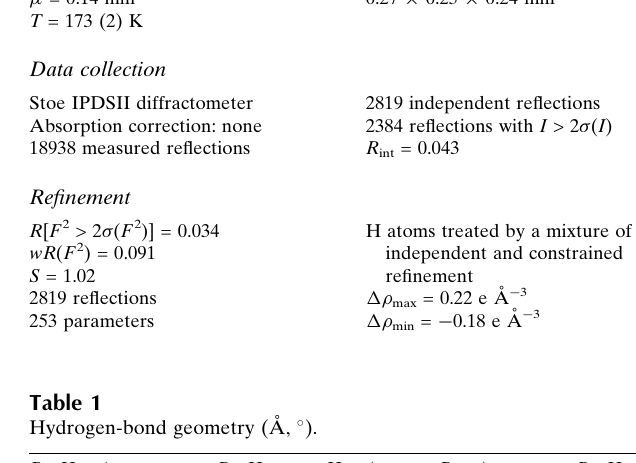
Hydrogen-bond geometry (A˚ , (cid:2)